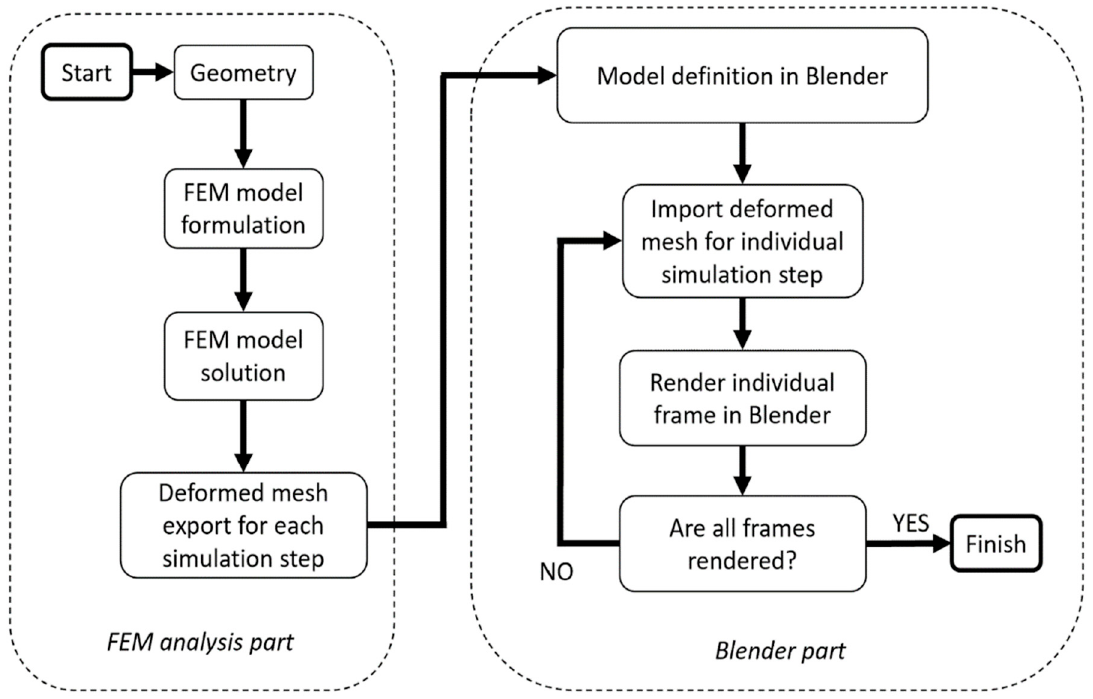
Figure 1. Scheme of the proposed simulation algorithm.